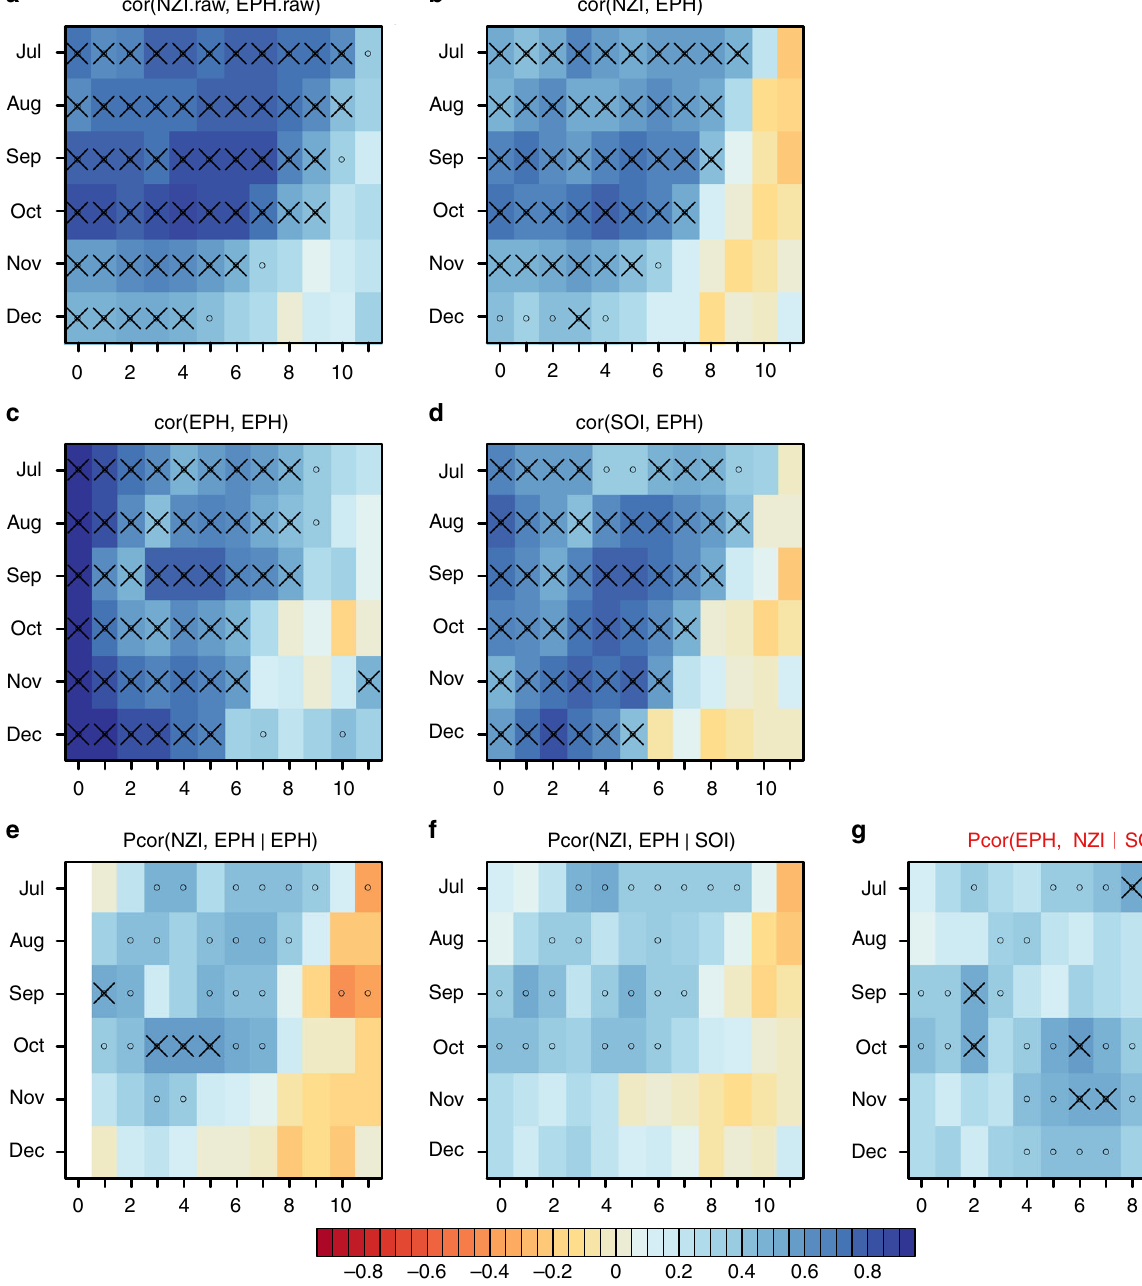
Fig. 1 Time-lagged Pearson correlations where y -axis refers to month of predictor and x -axis refers to the number of months that the predictand is lagged forward. SST anomalies are calculated relative to month-of-year climatology. a Correlation between raw NZI SST anomalies leading raw EPH SST anomalies without detrending, note in all other panels time-series have been linearly detrended prior to correlation; b correlation of NZI leading EPH; c correlation of EPH with EPH showing memory in EPH SST anomalies; d correlation of SOI leading EPH; e partial correlation of NZI leading EPH after controlling for EPH memory; f partial correlation of NZI leading EPH after controlling for SOI; g direction is reversed from f i.e. the partial correlation of EPH leading NZI after controlling for SOI. In all panels black circles indicate local signi fi cance at p < 0.05, black crosses indicate signi fi cance at p < 0.05 after controlling the false discovery rate (FDR) under multiple hypothesis testing. SST data is from JRA COBE-SST2 covering the period 1982 –